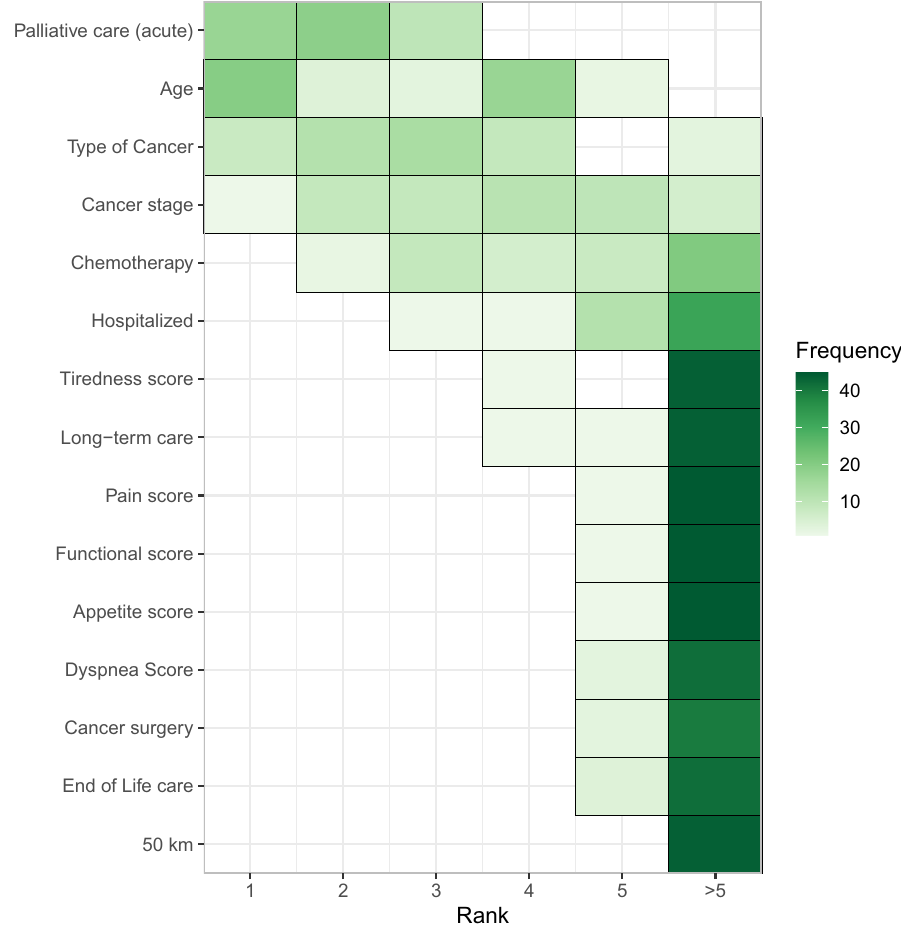
Figure 4. The number of times, frequency, a given feature is ranked, on top 5, by a particular model in a given cohort as one of the most important feature. Low rank means a particular feature is predictive and hence